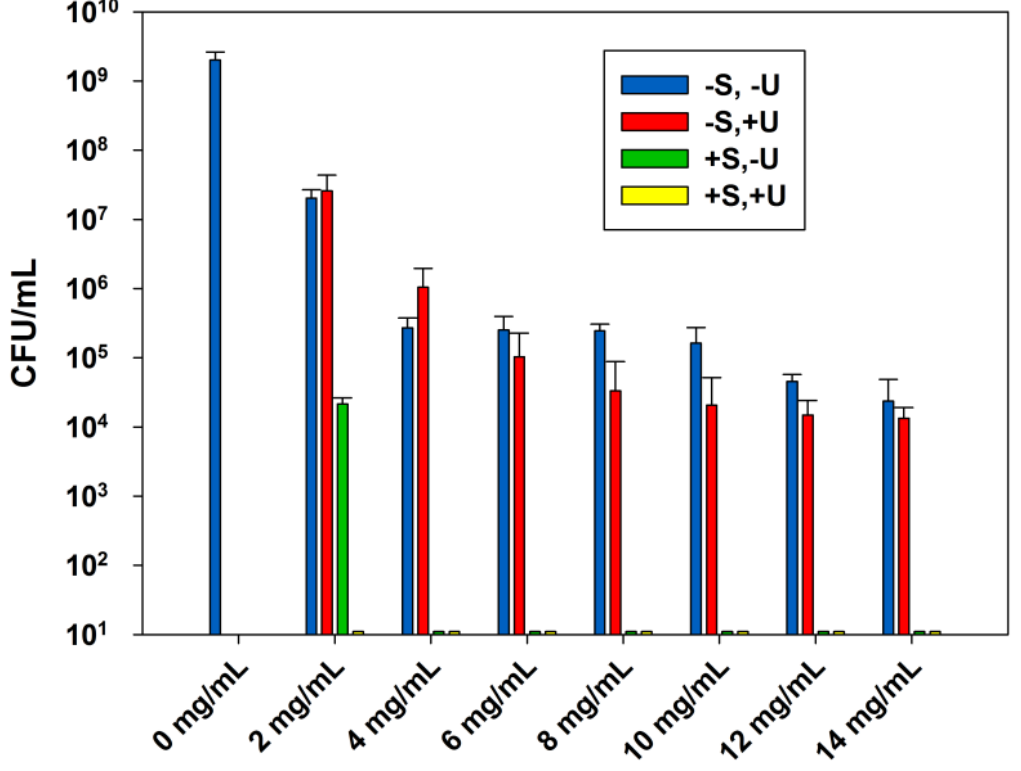
Figure 2. The effect of sterilization and ultrasound stimulations on the ABA of ZnO-UVM-7 (Si/Zn = 5) material, LB suspensions against E. coli (DH5α), after incubation at 37 °C for 24 h. Data are shown with mean values and standard errors of bacterial counts.